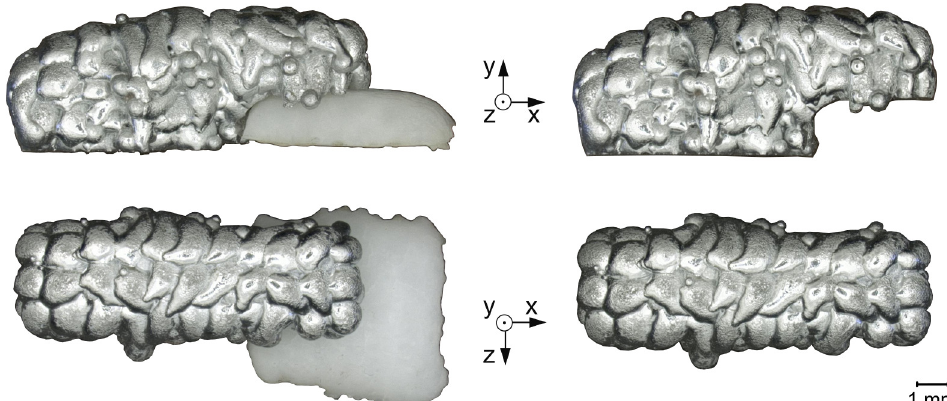
Figure 4. UL-sample with salt support structure and after support removal. The top row shows the sample viewed from the side, the bottom row viewed from